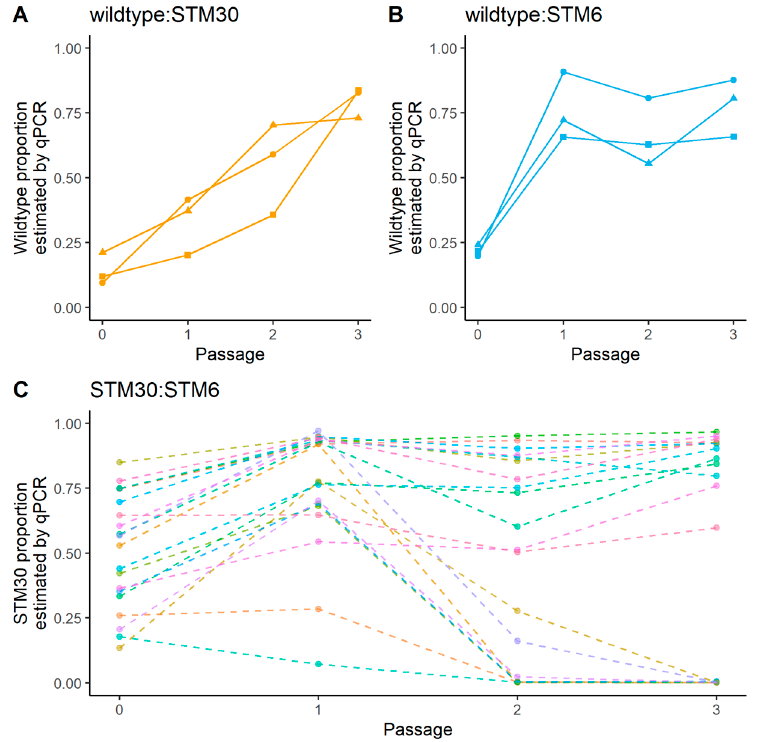
Figure 3. Change in proportion of more beneficial genotype over serial exposure to in planta growth in magenta boxes. The wild type was co-inoculated in three independent lineages with STM30 ( A ) and STM6 ( B ). The two mutants were co-inoculated together in 20 independent lineages ( C ). The proportion of the more beneficial genotype was estimated using qPCR at four different time points: the initial inoculation and after passages 1, 2, and 3 of in planta growth. The different colors in ( C ) represent the 20 lineage replicates of STM30 and STM6. The order of benefit provided by rhizobial symbionts is wild type > STM30 > STM6.